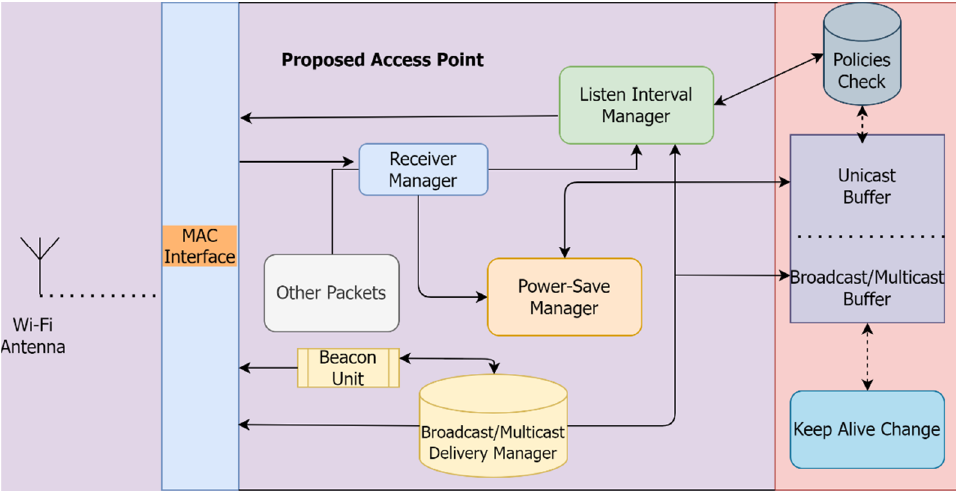
Figure 6. Proposed access point Framework.